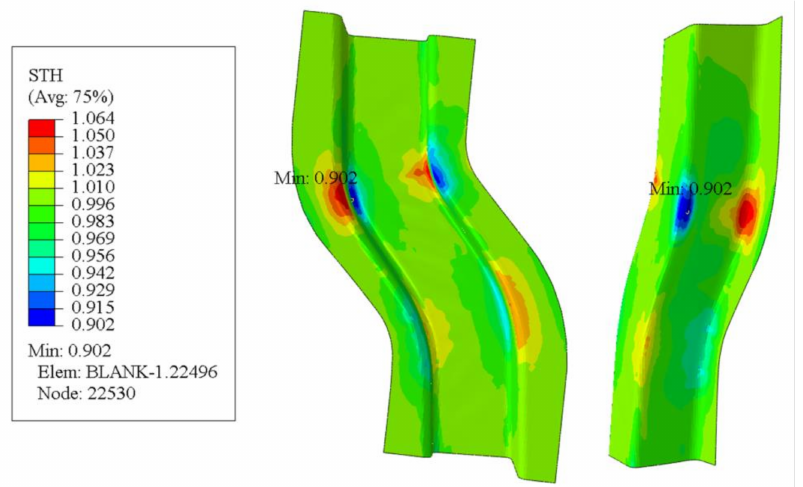
Figure 21. Thickness cloud map at stamping speed of 50 mm/s, friction coefficient of 0.1, and blank holder force of 5 kN, forming temperature 410 ◦